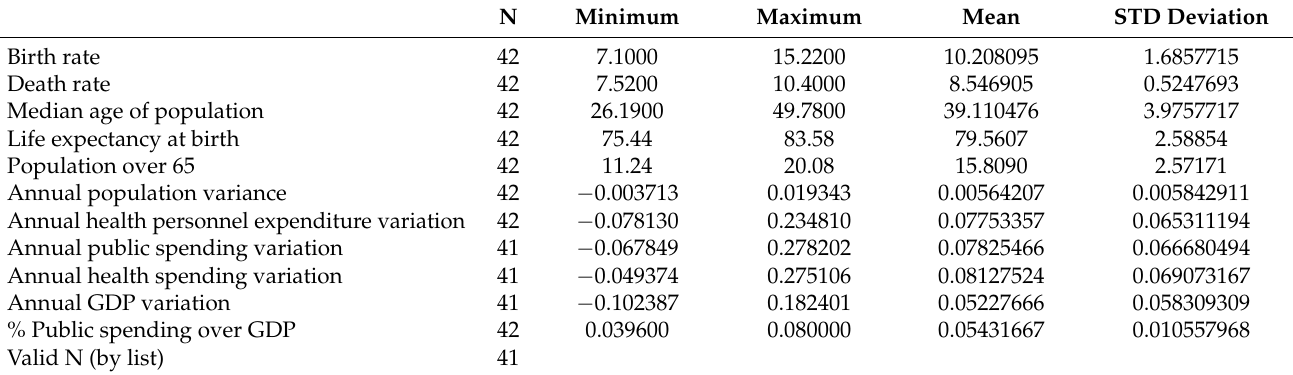
Table 1. Descriptive statistics.